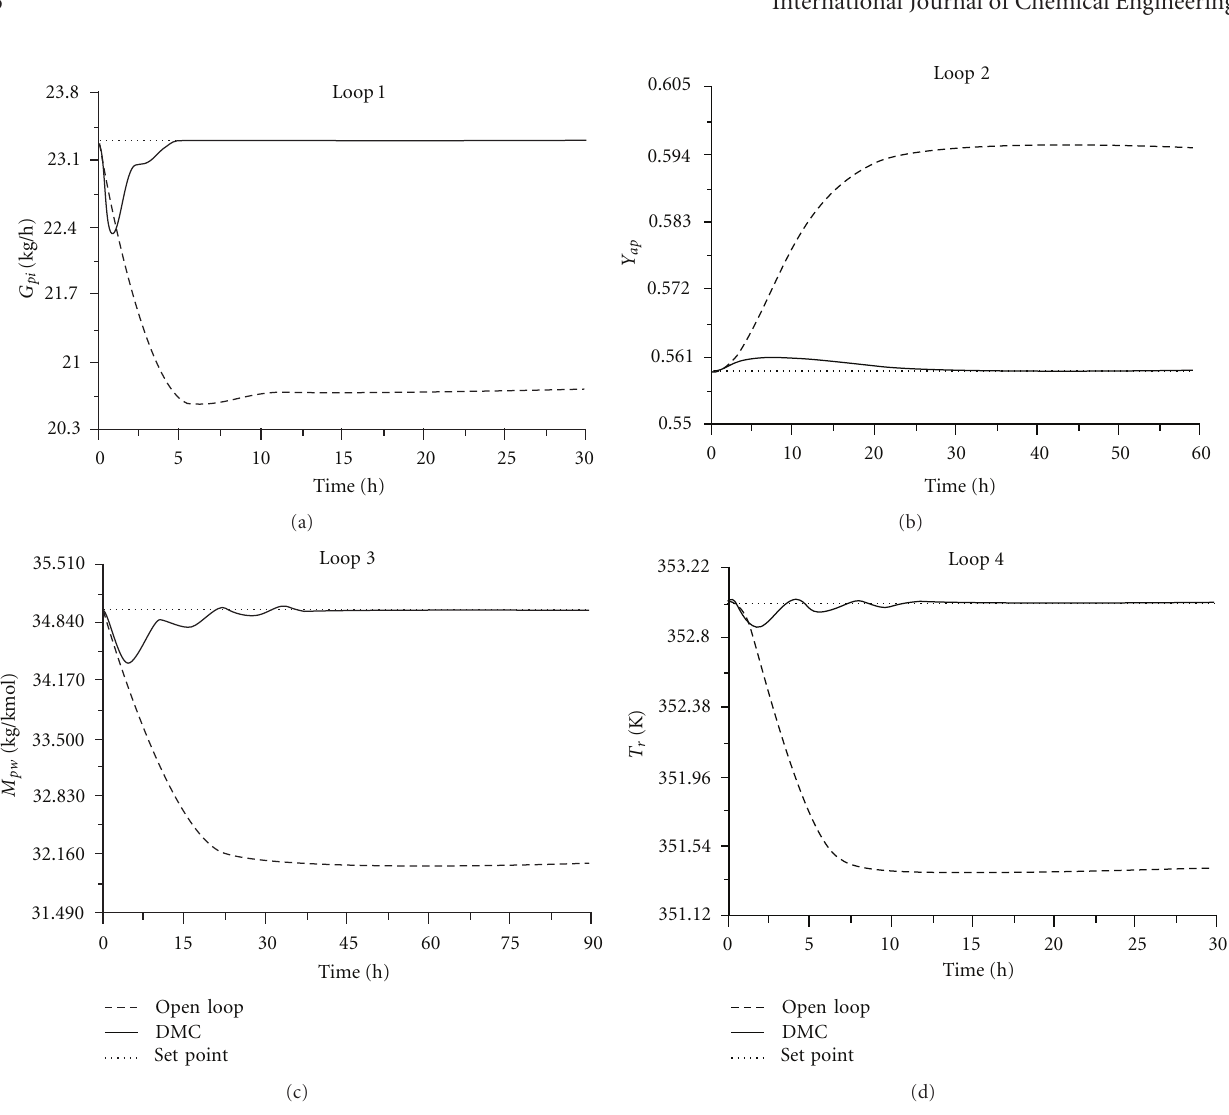
Reactor, separator, and hold tank contain pure solvent pre- heated to 353.15 K at